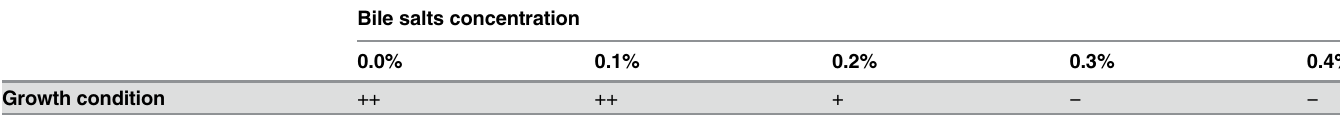
Growth condition ++ ++ + − − ++, CCFM8246has grown well in given bile salts concentration, the MRS liquid culture medium is turbid and megascopic cell precipitation can be clearly observed; +, CCFM8246 has grown slightly, the MRS liquid culture medium is turbid to a small extent and a little megascopic cell precipitation could be observed; − , CCFM8246 cannot grow, the culture medium is clear and transparent and no cell precipitation could be